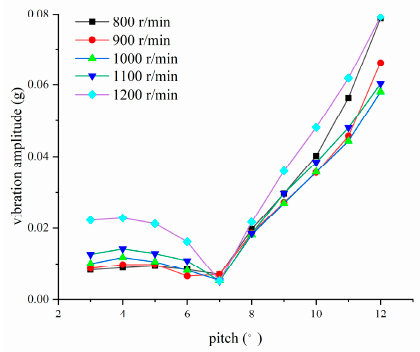
Figure 17. Lateral amplitude diagram of pitch.